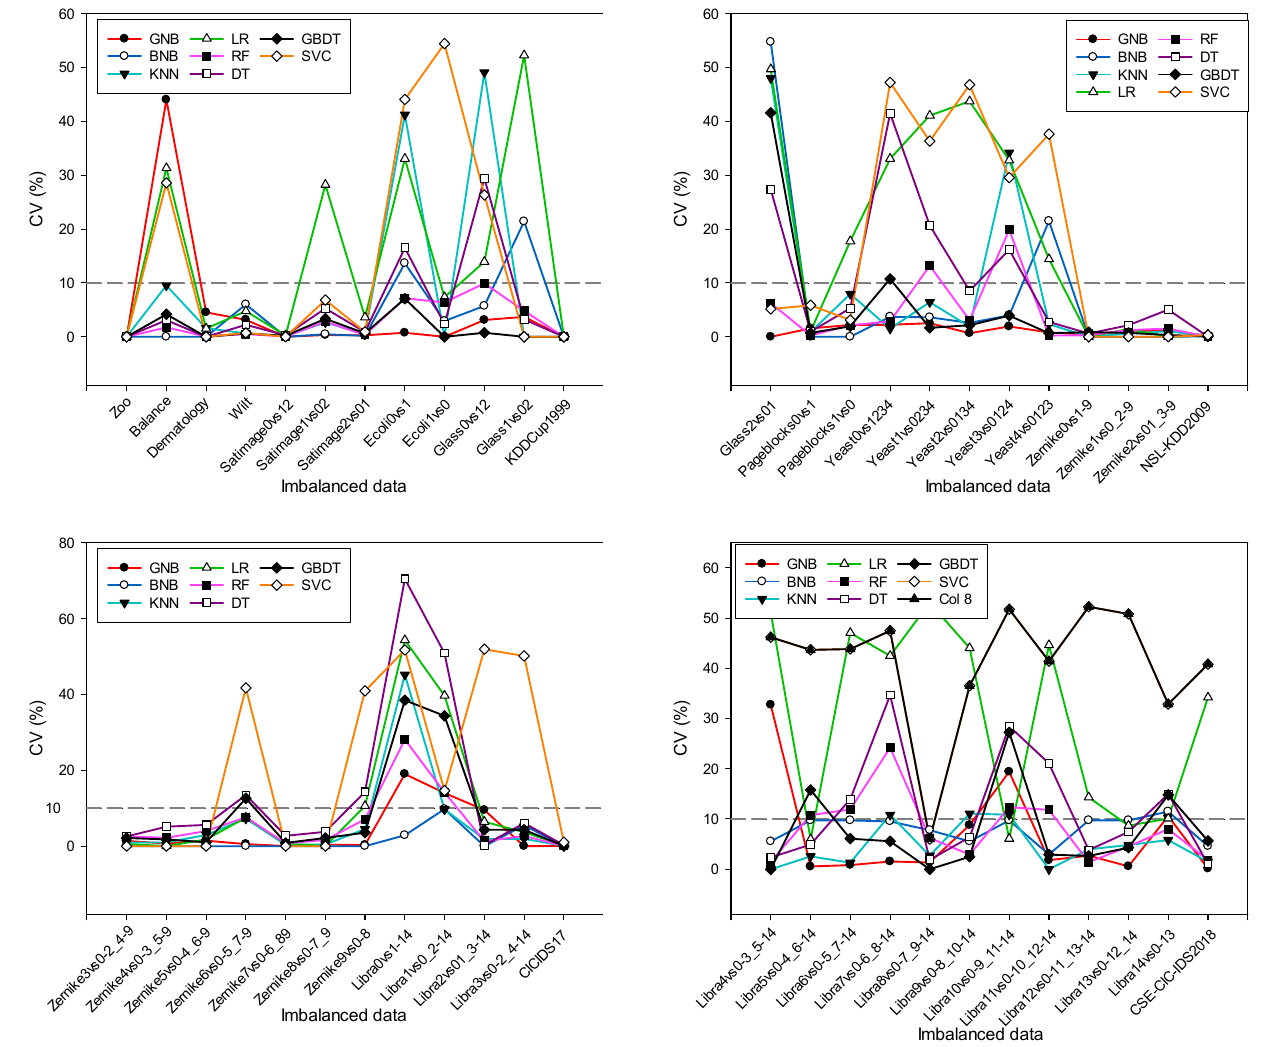
Figure 9. Performance stability of eight machine learning models on 48 imbalanced datasets.